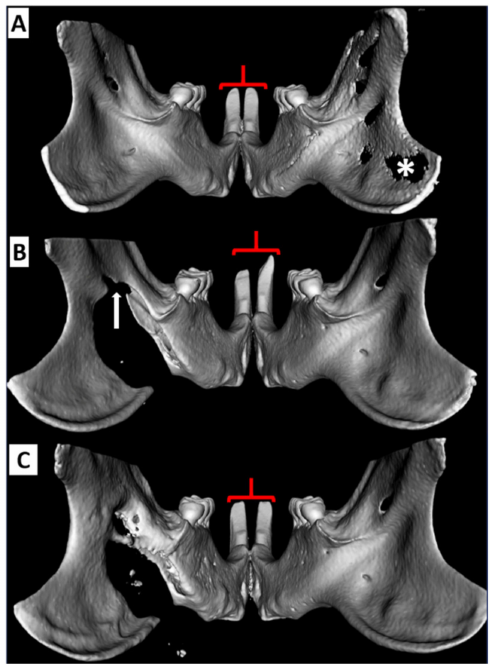
Figure 5. Reconstructed µ CT images showing effects of ligation of the left inferior alveolar NVB & ID in the rat incisors: ( A ) Baseline image prior to defect creation. Note the incisor symmetry (red brackets). Volume averaging of the thin ramus bone on the right results in the artifactual appearance of no bone (*). ( B ) One week following defect creation and ligation of the NVB (arrow). Note in this case that there is bilateral incisor dysmorphology but the incisor contralateral (to the defect) is considerably longer. ( C ) Three weeks following defect creation there is complete restoration of incisor length and morphology. CBCT = cone beam computed tomography, µ CT = micro computed tomography NVB: neurovascular bundle, ID: intermediate